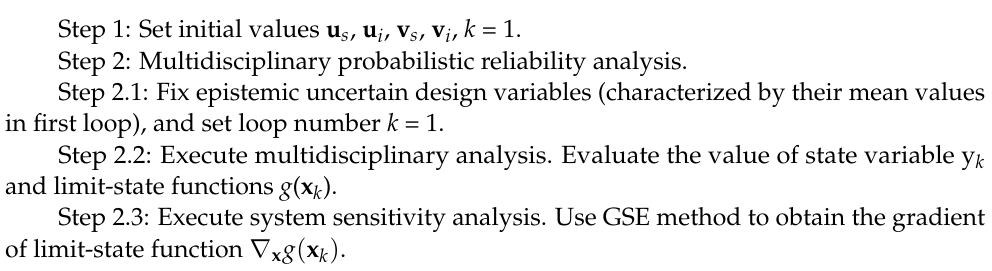
Figure 5. The decoupling strategy for multidisciplinary reliability analysis approach.